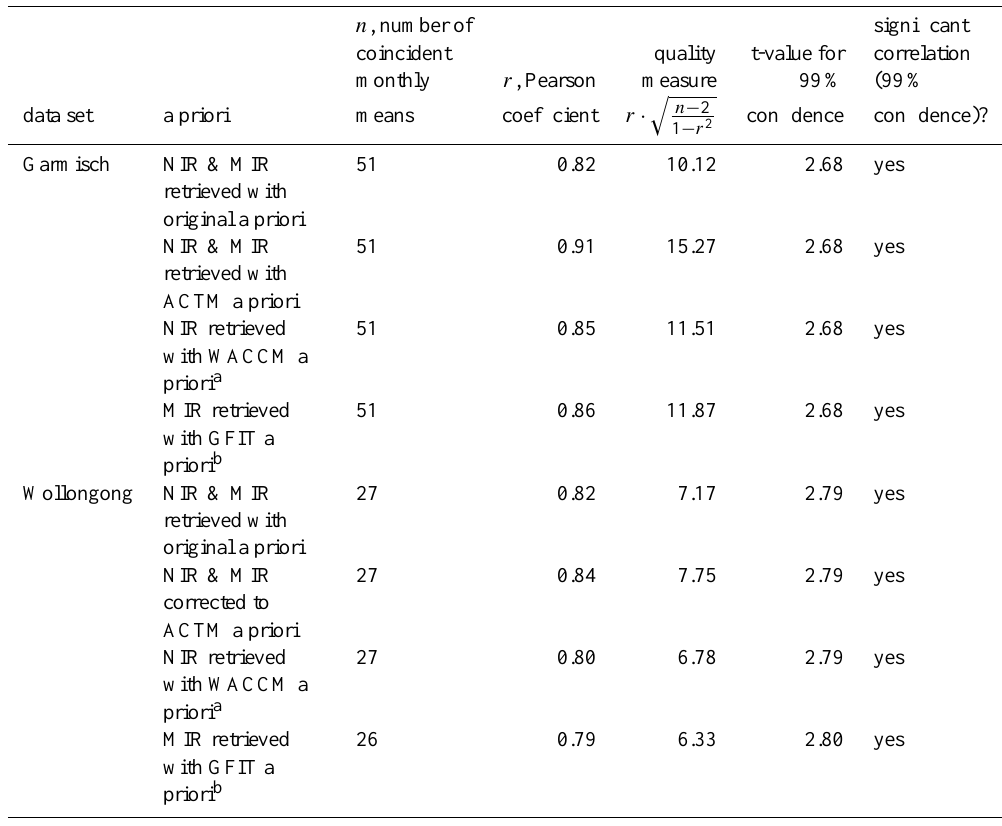
Table 4. Significance of correlation between multi-annual data sets of NIR and MIR XCH 4 retrievals using varied a priori profiles. Signif- icant correlation is achieved if the quality measure (5th column) exceeds the t-value. Data are monthly means constructed from same-day measurement coincidences. n , number of significant coincident t-value